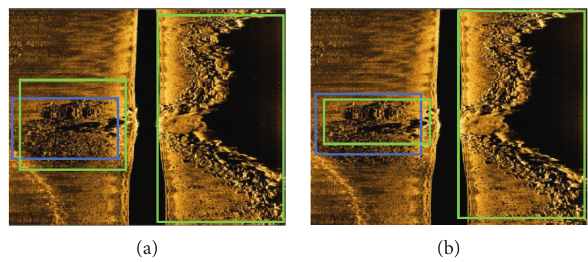
Figure 9: Comparison of detection results of texture features in large area.